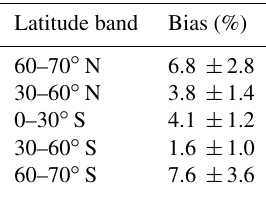
Table 4. Mean relative differences and standard deviation (in per- cent) between IASI-A and SAOZ total ozone for different latitude zones and daytime